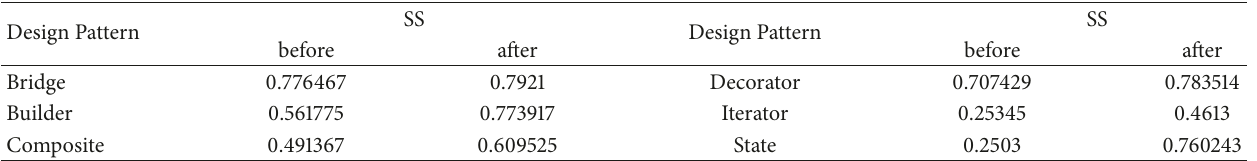
Table 4: Descriptions of the subject software